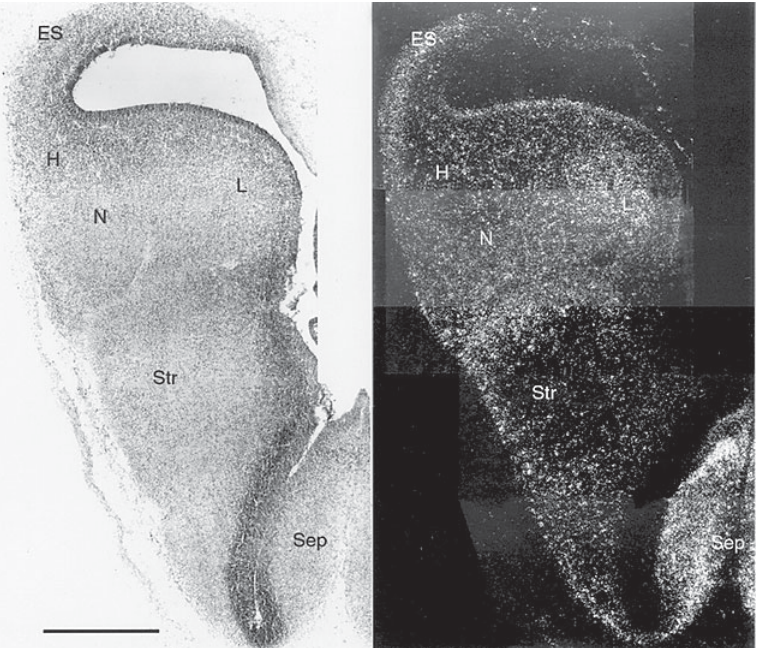
Figure 7. Reelin mRNA expression in the chick embryonic cortex. Bright and dark field view of a coronal section through a chick embryo. In situ hybridization with a [ 33 P]-labeled, species-specific reelin riboprobe. The cortical plate is diminutive and has an intermediate level of radial organization. It is reelin negative whereas the marginal zone contains a few reelin-positive neurons. ES: eminentia sagittalis (Wülst); H: hyperstriatum; N: neostriatum; L: area «L»; Str: striatum; Sep: septum. Adapted from Ref. 19. Magnification bar: 500